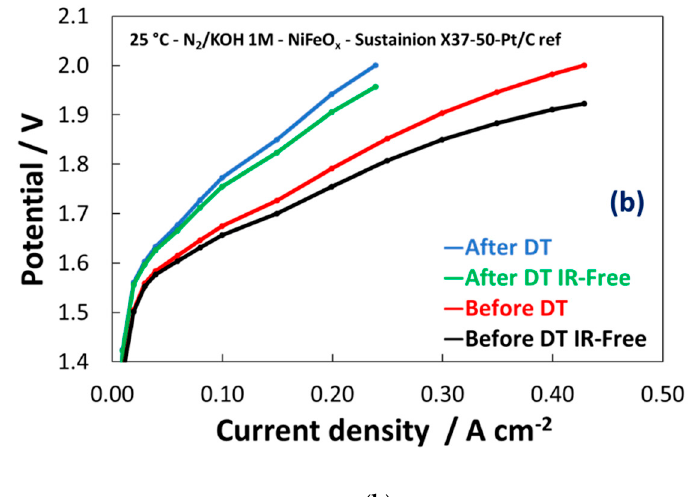
Figure 9. Potential cycling test (1–1.8V) for the NiFeO x KB (1:1) catalyst with the Sustainion ™ membrane in 1M KOH ( a ) and polarization curves for the NiFeO x KB 70:30 catalyst based MEA before and after the accelerated stress test ( b ).